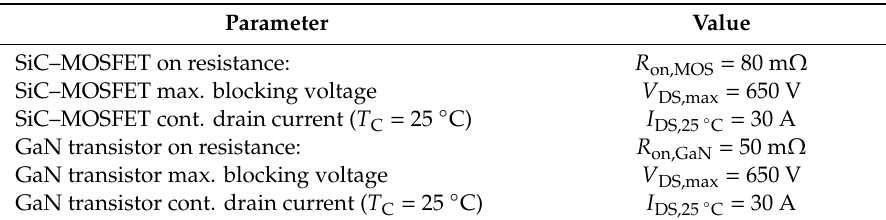
Table 6. Relevant SiC MOSFET and GaN transistor